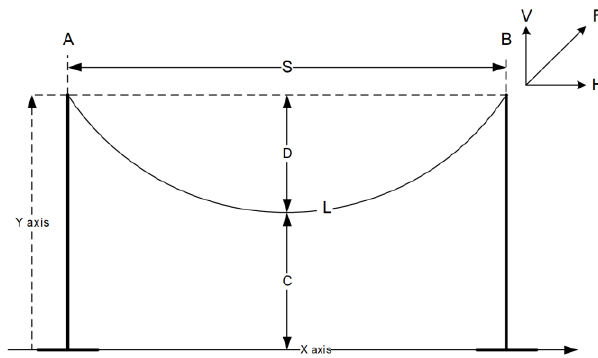
Figure 4. The conductor length, sag, clearance, and tension in a transmission line span.